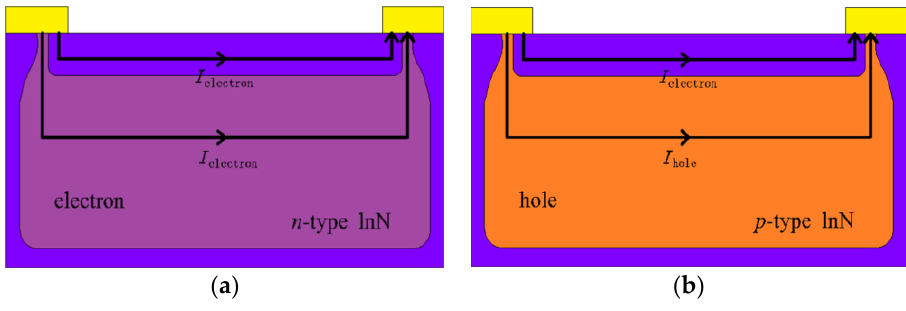
Figure 1. Schematic diagrams of conduction mechanism for n-type ( a ) and p-type ( b ) InN sensors.